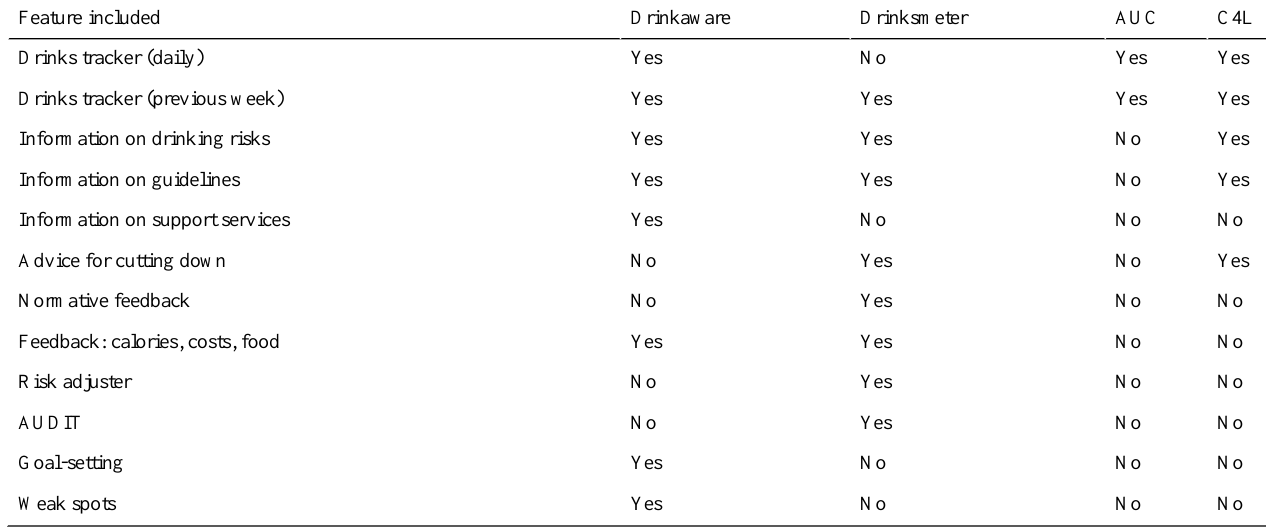
Table 1. Description of app